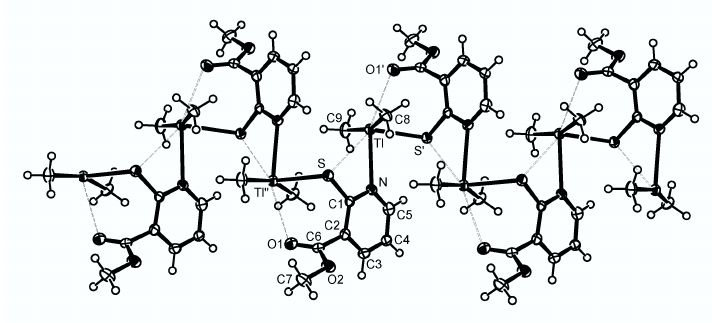
Fig. 3 ORTEP plot showing the numbering scheme and the supramolecular association in [TlMe 2 (2mmn)] ( 2 ).